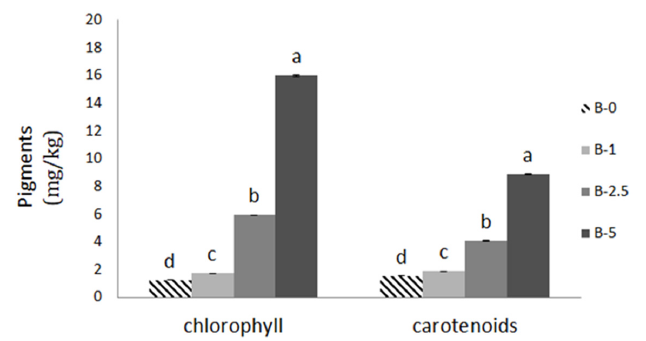
Figure 4. Concentration (mg/kg) of pigments (chlorophylls and carotenoids) in Buža olive cultivar oil obtained without (B-0) and with the addition of different amounts of olive leaf: 1% (B-1), 2.5% (B-2.5) and 5% (B-5). Results represent mean values of three technical repetitions ± standard deviations. Different letters above bars represent significant differences among the treatments (Tukey´s test, p < 0.05) for each parameter separately.